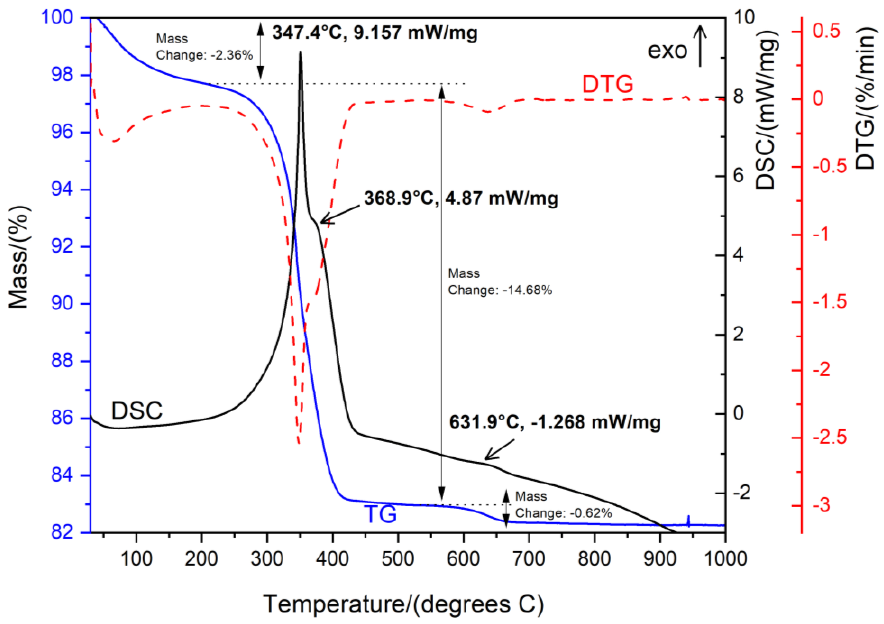
Figure 2. TG – DSC curves of naked MIONPs. Figure 2. TG–DSC curves of naked